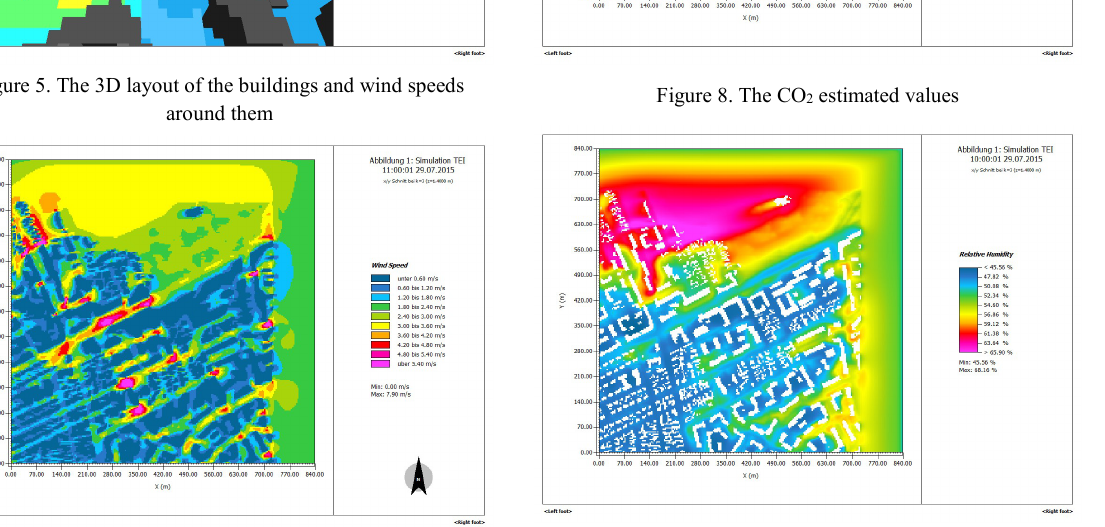
Figure 6. The wind speeds attained in the entire district